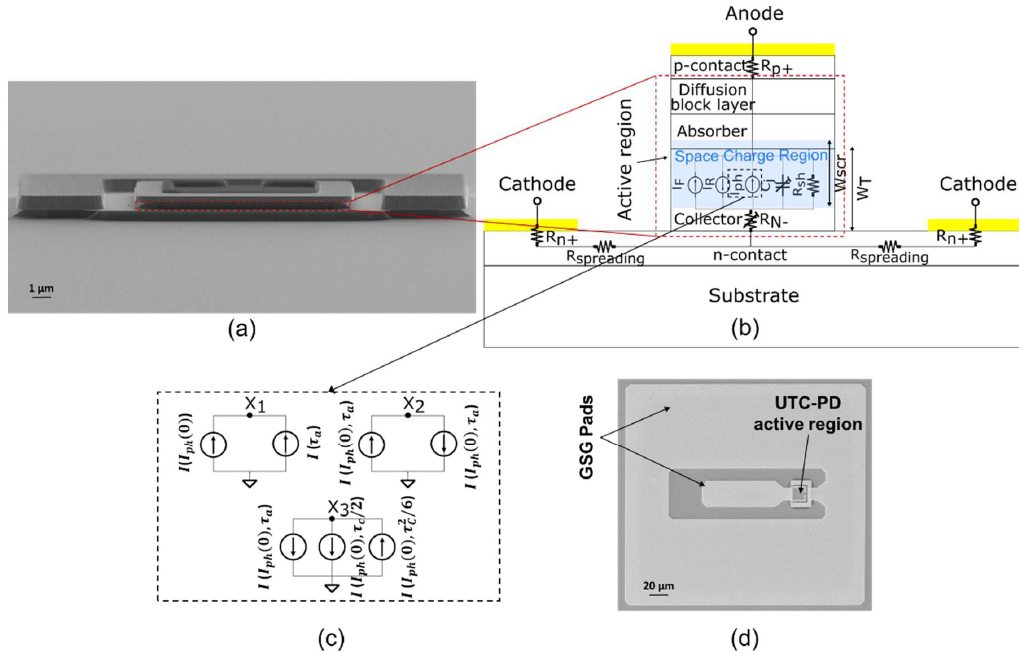
Figure 2. ( a ) SEM micrograph of a GaInAsSb/InP UTC-PD; ( b ) Schematic of the intrinsic mesa UTC-PD showing the location of the equivalent circuit elements; ( c ) the Verilog-A topology of the UTC-PD photocurrent transfer function; ( d ) Top-view SEM micrograph of a GaInAsSb/InP UTC-PD connected to the GSG pads.